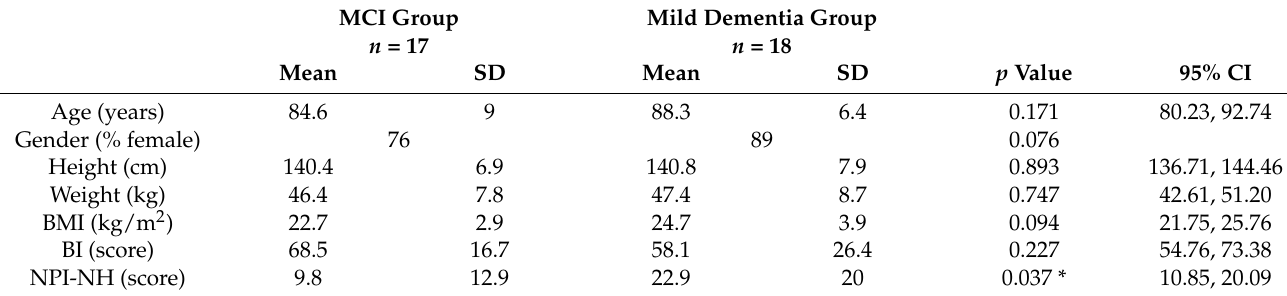
Table 1. Characteristics of participants.